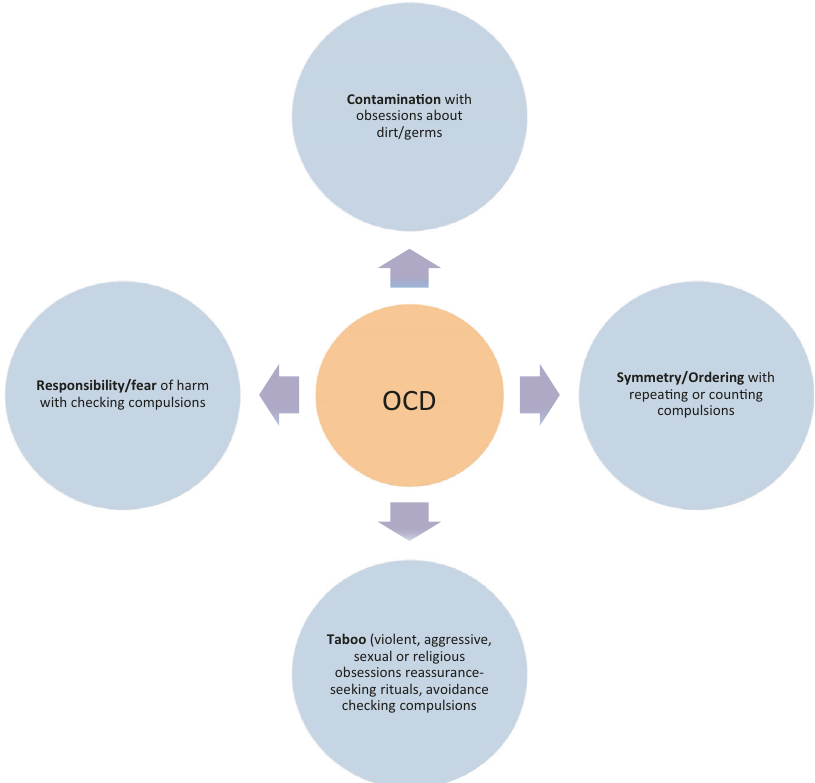
Fig. 2 OCD symptom sub-types. OCD symptoms are classically de fi ned by four subtypes, including (1) responsibility/fear of harm (obsessions regarding responsibility and checking compulsions such as asking for reassurance or checking that harm did not occur to someone), (2) contamination (obsessions about dirt or germs or other possible contaminants and cleaning compulsions), (3) symmetry/ordering (obsessions about symmetry or order and ordering, repeating or counting compulsions), and (4) taboo (violent, aggressive, sexual or religious obsessions with reassurance-reeking rituals, avoidance or checking for harm) [1 –